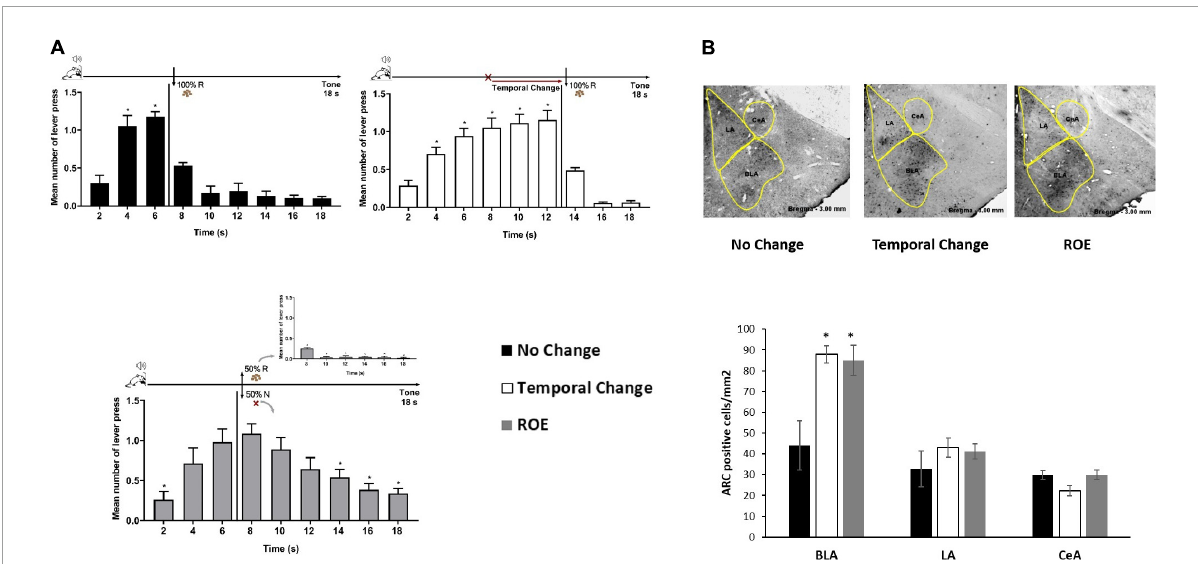
FIGURE2 Basolateral amygdala nuclei are activated by the prediction error due to a change in the temporal rule and reinforcement omission. (A) Error session: responses average (+ SEM) during the 18 s tone, per 2 s, for three groups: No Change (Black columns; n = 9) during FI 6 s LH 12 s signaled schedule (* p < 0.05, post hoc intra-group differences from 2 s); Temporal Change (White columns; n = 10) during FI 12 s LH 6 s signaled schedule during which the FI time was delayed to 12 s to obtain the reward (* p < 0.05, post hoc intra-group differences from 2 s); reinforcement omission effect (ROE) (Gray columns; n = 10) during FI 6 s LH 12 s signaled schedule during which the reward was omitted in 50% of trials (* p < 0.05, post hoc intra-group differences from 6 s). (B) Activity-regulated cytoskeletal (ARC) activation: Quantification of the number of Arc-positive cells per square millimeter (mean ± SEM) across basolateral (BLA), lateral (LA) and central (CeA) posterior amygdala nuclei of No Change (Black columns), Temporal Change (White columns) and ROE (Gray columns) groups in animals perfused 90 min from the beginning of the Error session. Arc expression is increased in the BLA when the time to reward was changed from 6 to 12 s, as well as when the reinforcement was omitted (* p < 0.05, post hoc differences from No Change group). FI, fixed-interval; LH, limited hold; R, Reinforcement; N,